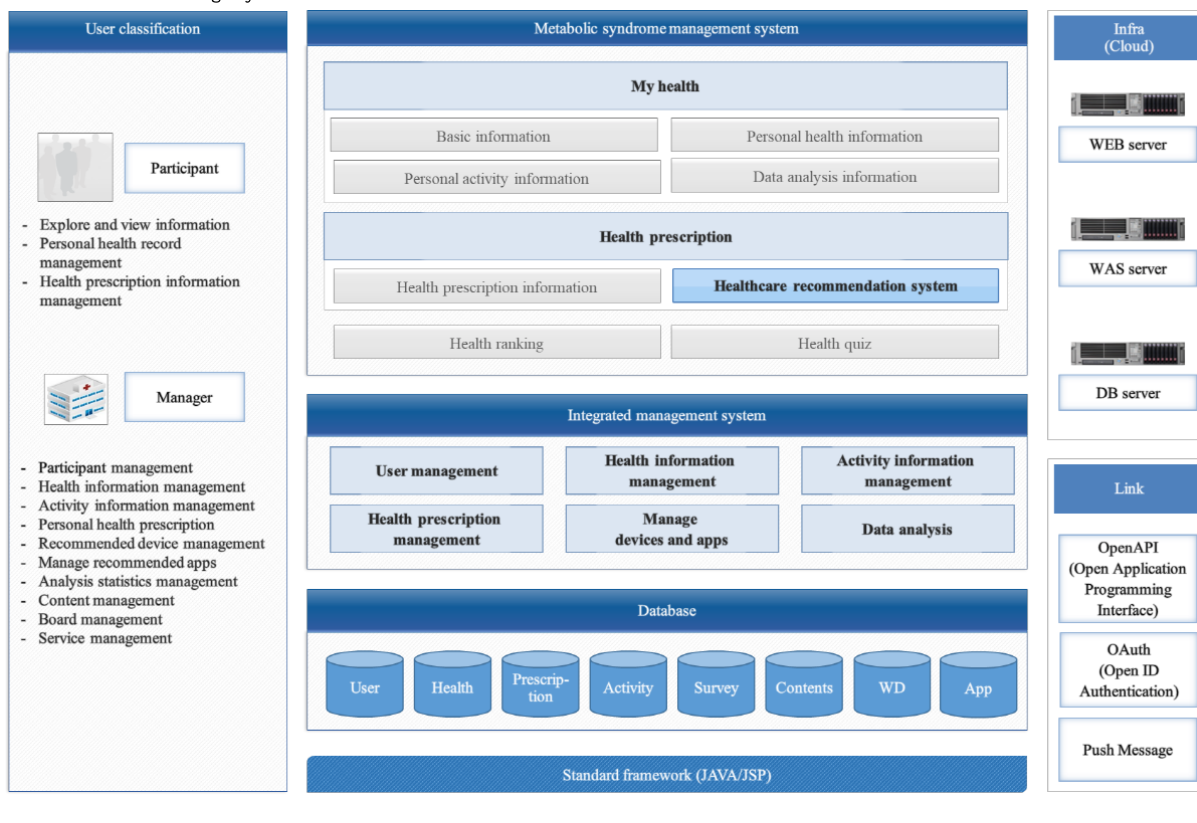
Figure 3. E-Motivate4Change system architecture.